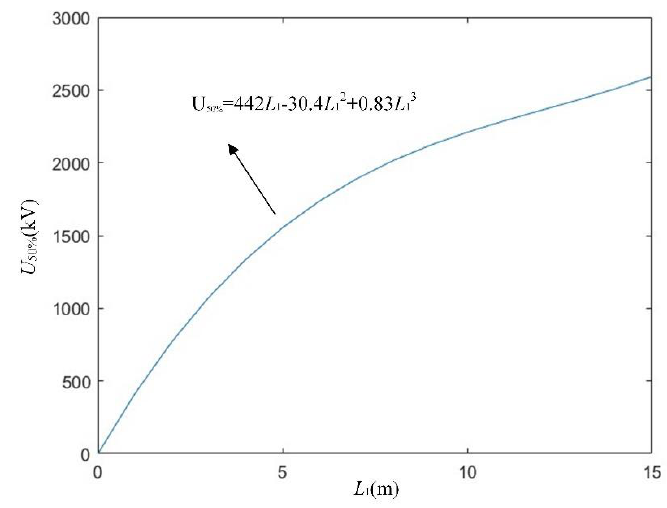
Figure 2. AC discharge characteristics of the conductor gap.